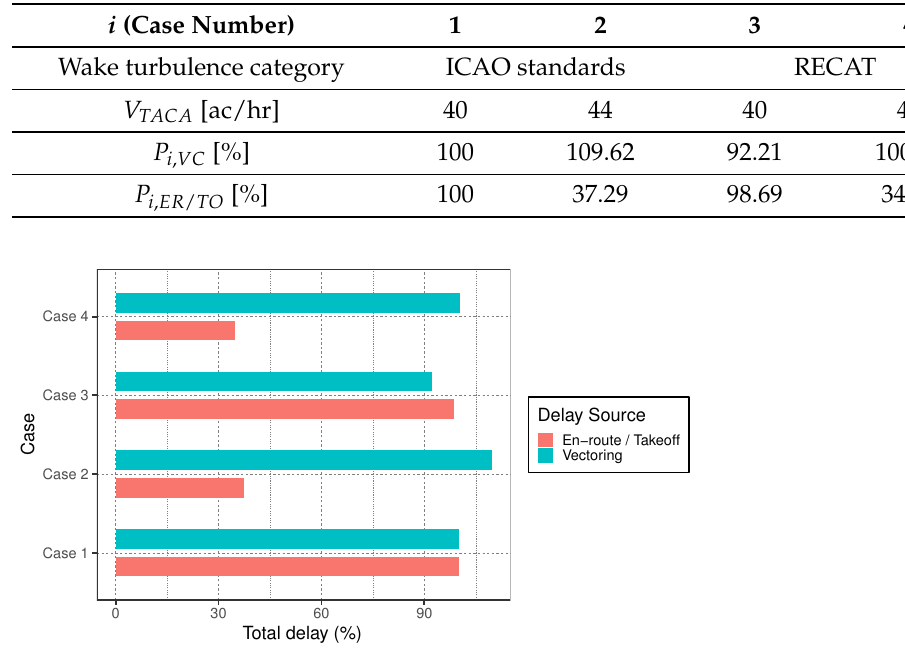
Table 12. Summary of the percentage of the total delay for flights arriving at runway 34L in RJTT compared with Case 1.